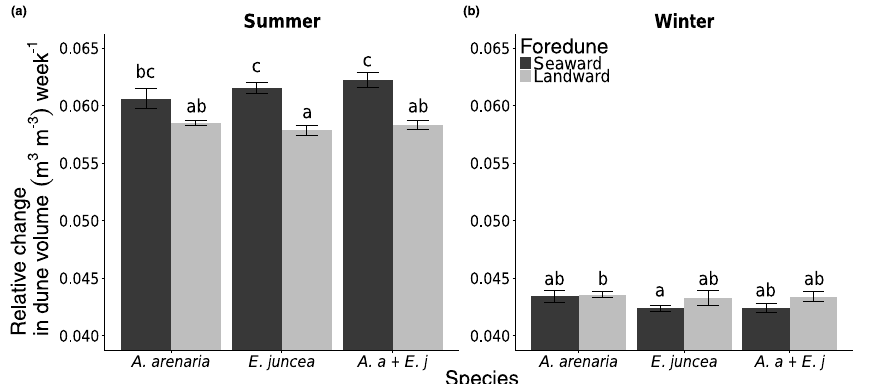
Figure 6. Relative change in dune volume (m 3 m − 3 )week − 1 for nebkha dunes with A. arenaria , E. juncea and a mix of both species and separated for dunes seaward and landward of the foredune for (a) summer, April–August; (b) winter, November–April. The letters denote the significant difference between the bars. Seaward of the foredune there were 28 dunes with A. arenaria , 77 dunes with E. juncea and 28 dunes with both species. Landward from the foredune there were 57 dunes with A. arenaria , 22 dunes with E. juncea , and 25 dunes with both